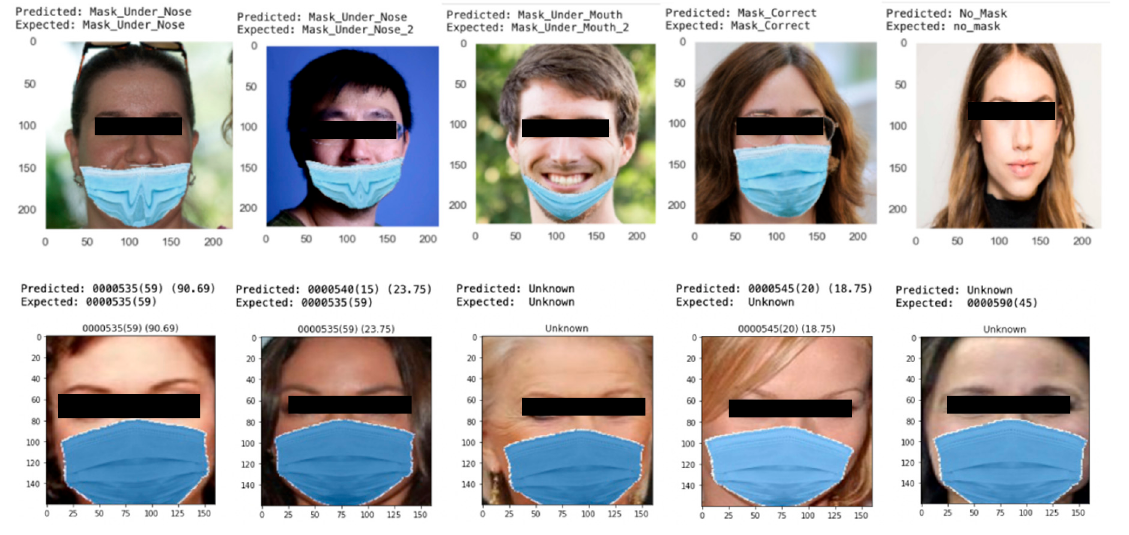
Figure 13. Testing Results.